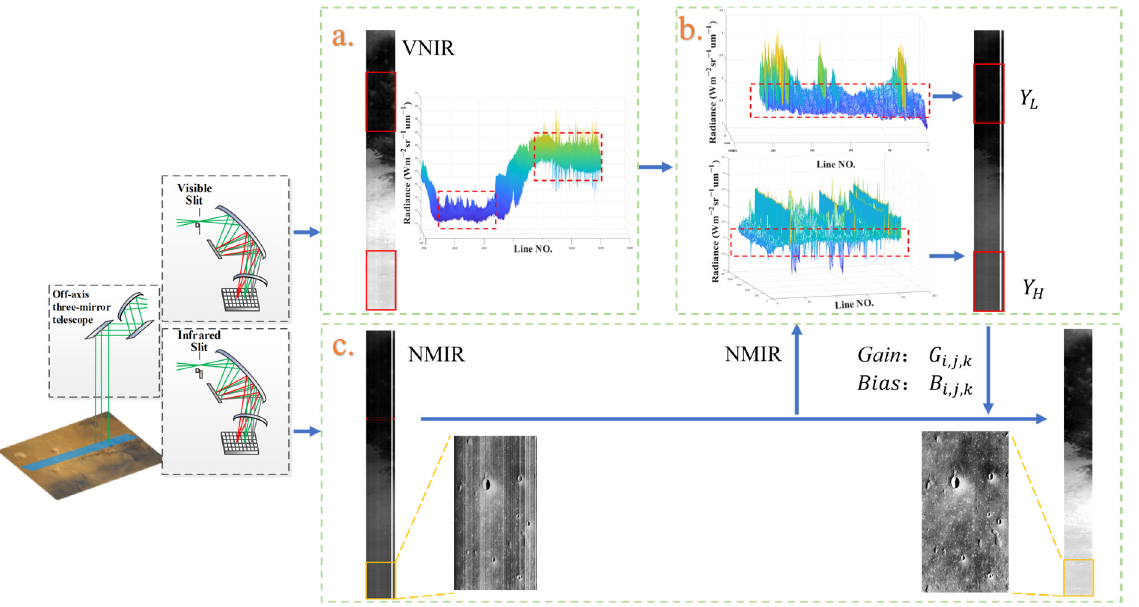
Figure 5. MMS uniform region selection and correction flow chart. ( a ) Initial V ‐ NIR selection of a uniform region in the time dimension, ( b ) further V ‐ NIR selection of the uniform region in the spatial dimension, and ( c ) the N ‐ MIR spectral band for the NUC.